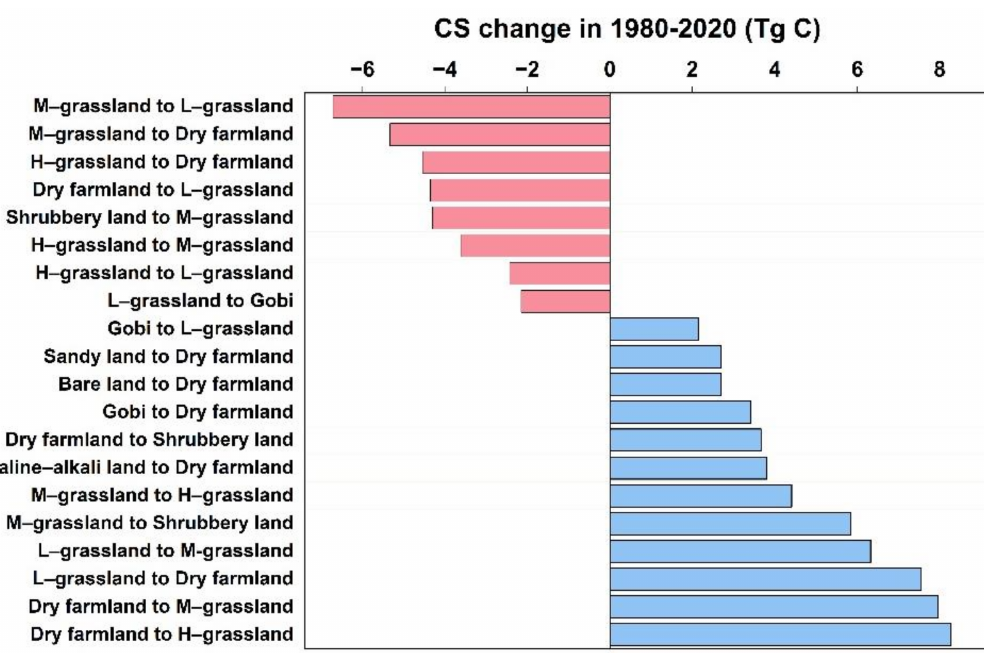
Figure 6. Carbon storage change in the Gansu province from 1980 to